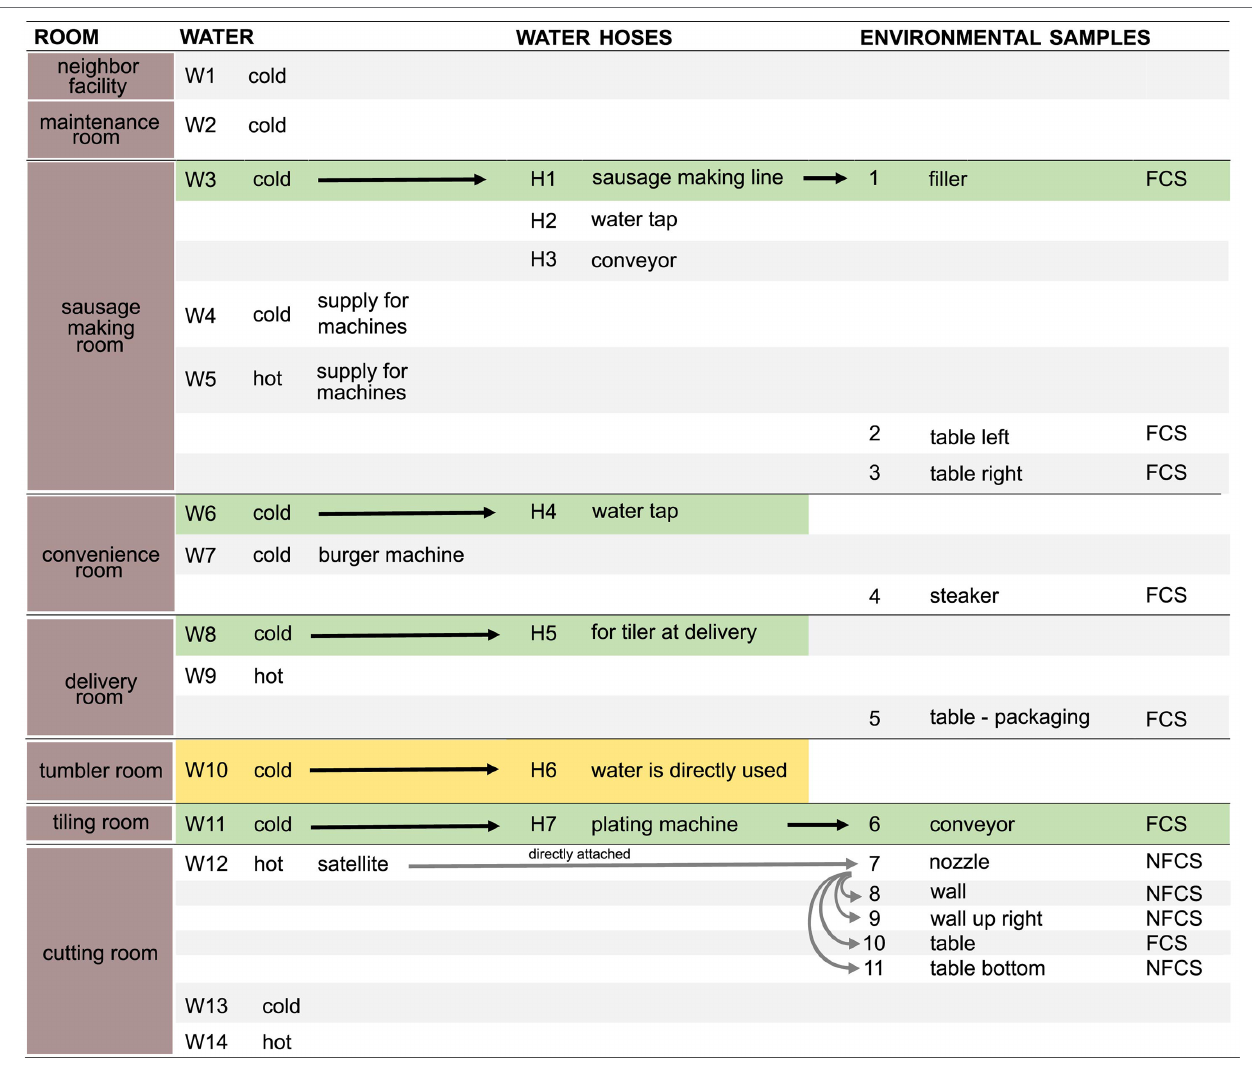
FIGURE 1 | Schematic overview of samples. Water ( n = 14, W1–W14), water hoses ( n = 7, H1–H7), and environmental surfaces ( n = 11, E1–E11) were sampled in different rooms. Arrows indicate a direct transfer of the water through the water hose to the environmental surface. Pairs of directly associated water, hoses, and environmental samples are highlighted in green. Rooms in which water is directly used for food production are highlighted in yellow. Food Contact Surface (FCS); Non-Food Contact Surface (NFCS). Detailed information on environmental samples are found in Supplementary Table 2